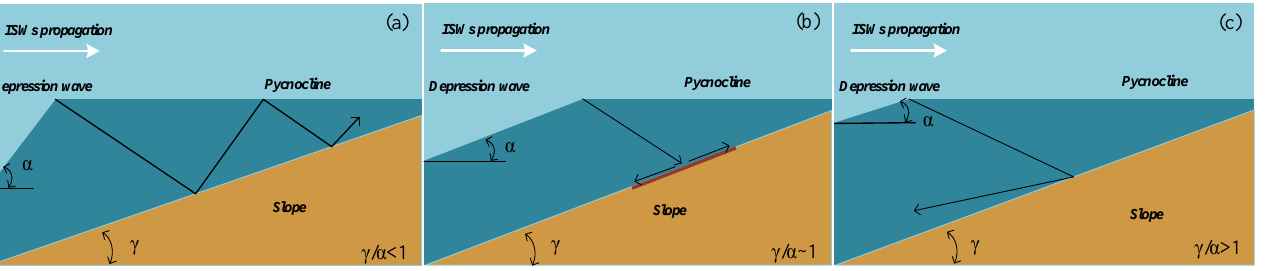
Figure 4. Reflection of internal solitary wave characteristics over slope (see references [7,8] for details about this particular event). ( a ) Transmissive regions ( γ / α < 1), ( b ) critical regions ( γ / α ~1), and ( c ) reflective regions ( γ / α > 1).